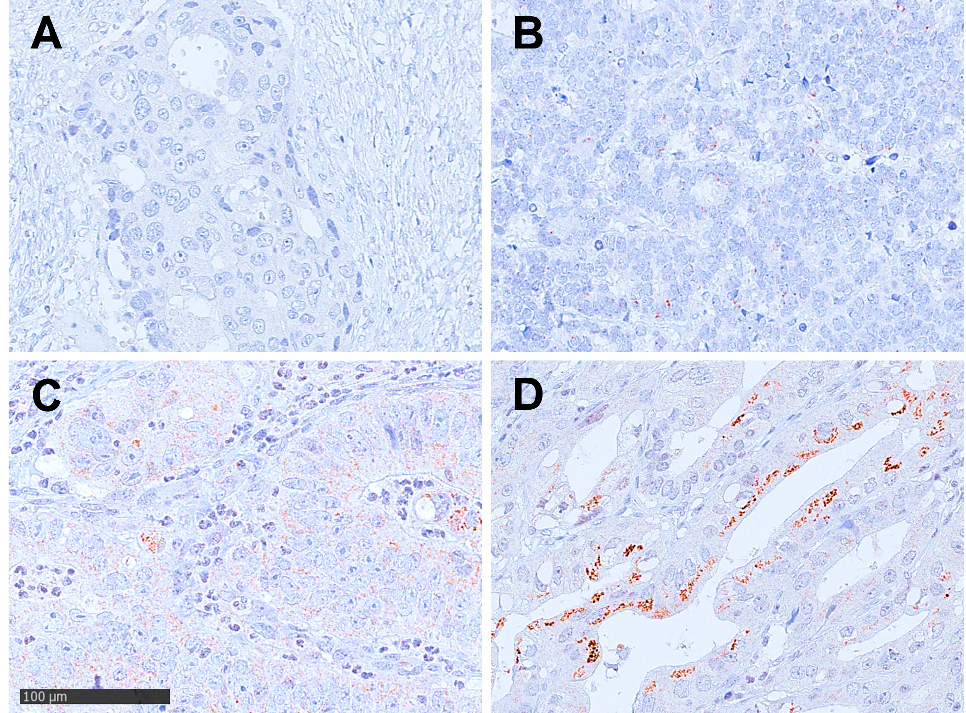
Figure 1. Immunohistochemistry of Dickkopf-2 (DKK2) in esophageal adenocarcinoma according to a 4-tier-scoring system; magnification × 400 ( A ) Negative staining for DKK2 (Score 0); ( B ) weak staining in tumor cells (Score 1 + ); ( C ) weak to moderate staining in most tumor cells (Score 2 + ); ( D ) strong staining pattern in > 30% of the tumor cells (Score 3 +